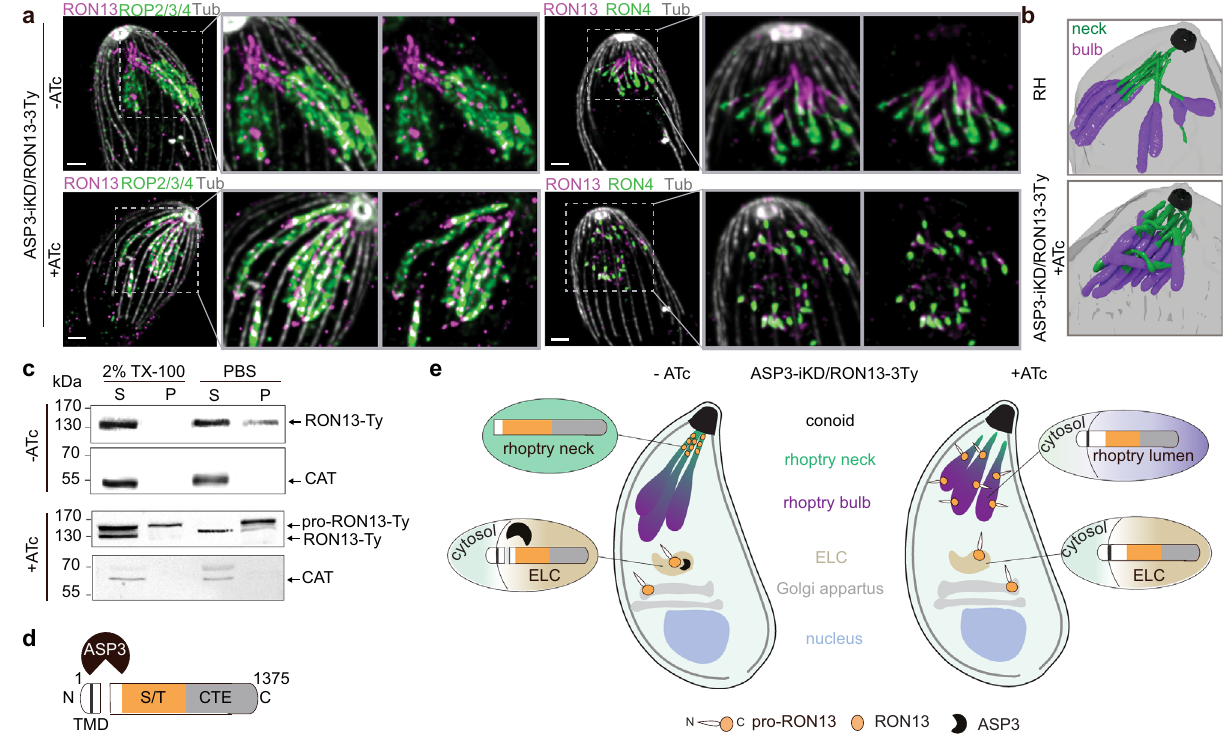
Fig. 1 RON13 is a RON kinase processed by ASP3. a U-ExM images of rhoptries from ASP3-iKD/RON13-3Ty extracellular parasites ± anhydrotetracycline (ATc). RON4 (green) and ROP2/3/4 (green) antibodies are used to visualize the neck and the bulb of the rhoptries, respectively. RON13-3Ty (magenta) is detected by anti-Ty antibodies. The subpellicular microtubules (gray) are stained with α / β anti-tubulin antibodies. Scale bar = 2 µ m. Image representative of three biologically independent experiments. b 3D reconstruction from FIB-SEM images of the apical part of RH (control) and ASP3-iKD parasites treated 48 h with ATc. The neck (green) and the bulb (violet) of the rhoptries are colored. The conoid (black) and the PM (gray) are depicted. n = 1 biologically independent experiment. c Solubility of RON13 in ASP3-iKD/RON13-3Ty parasites ±ATc. Catalase is a marker of the soluble fraction. Samples derived from the same experiment and gels were processed in parallel. Image representative of three biologically independent experiments. d Scheme of RON13 protein and its cleavage by ASP3 just downstream the transmembrane domain (TMD). S/T serine/threonine kinase domain (orange), CTE C-terminal extension (gray). e Scheme representing the fate of RON13 in presence or in absence of ASP3. Without processing by ASP3, RON13 remains insoluble and mistargeted to the body of morphologically aberrant rhoptries. ELC endosome-like compartment. Source data are provided as a Source data fi Fig. 5a, b). Analysis of RON13 electrostatic potential highlighted a rather extended positively charged groove lying on one side of the kinase that may be involved in protein – protein interactions, but did not provide strong hints to the role the CTE plays (Supple- mentary Fig. 5c).